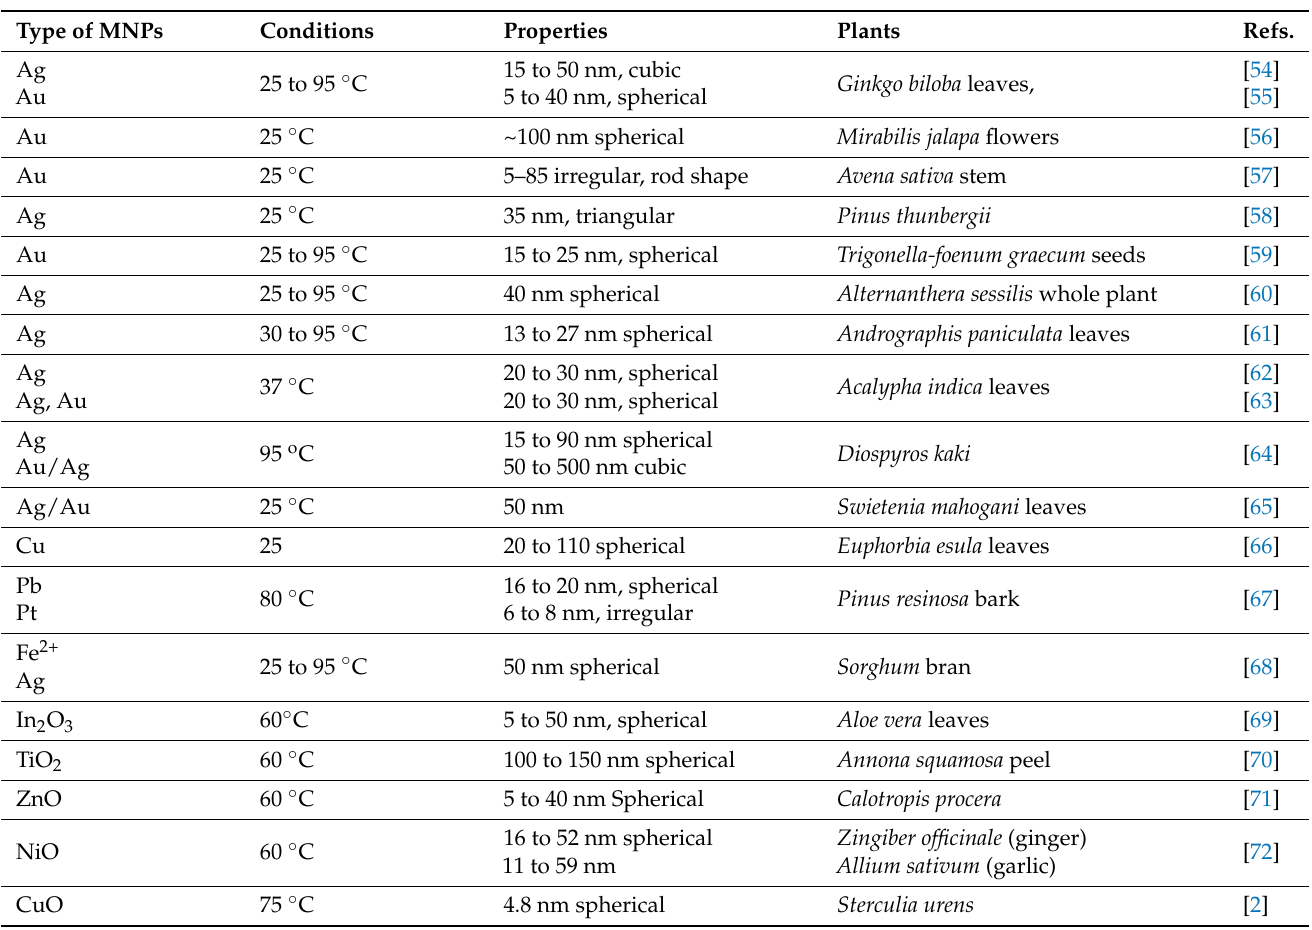
Table 1. Examples of metal-based nanoparticles synthesized using plant